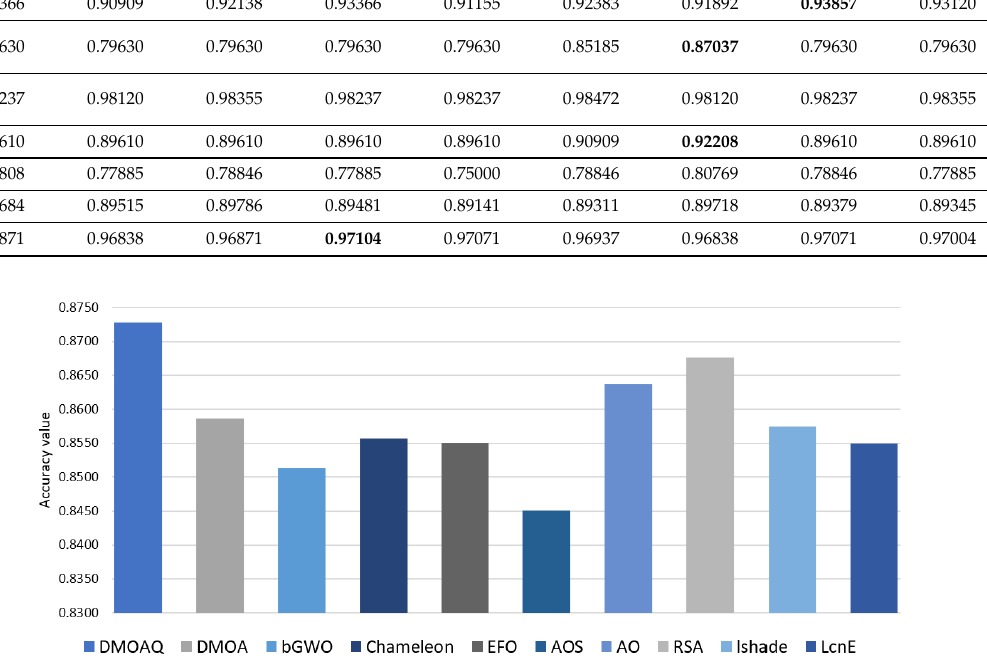
Figure 9. Average of the classification accuracy for all datasets.